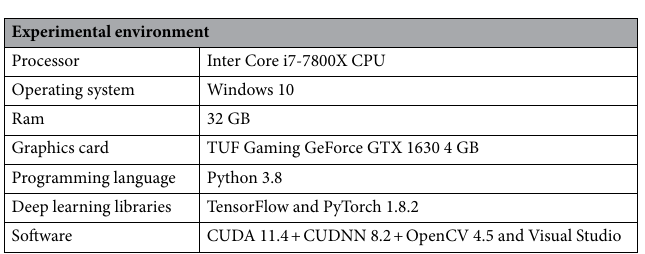
Table 1. Experimental conditions, hardware configurations and software